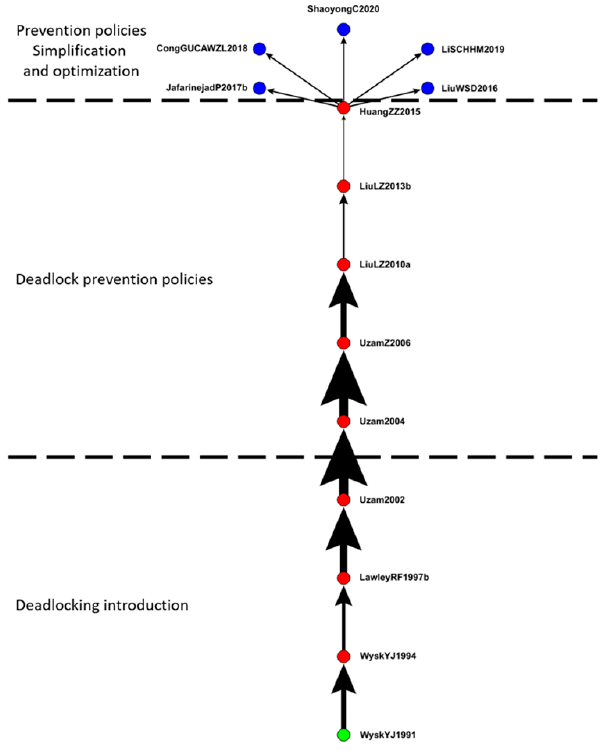
Figure 7. Global main path of FMS deadlock prevention.